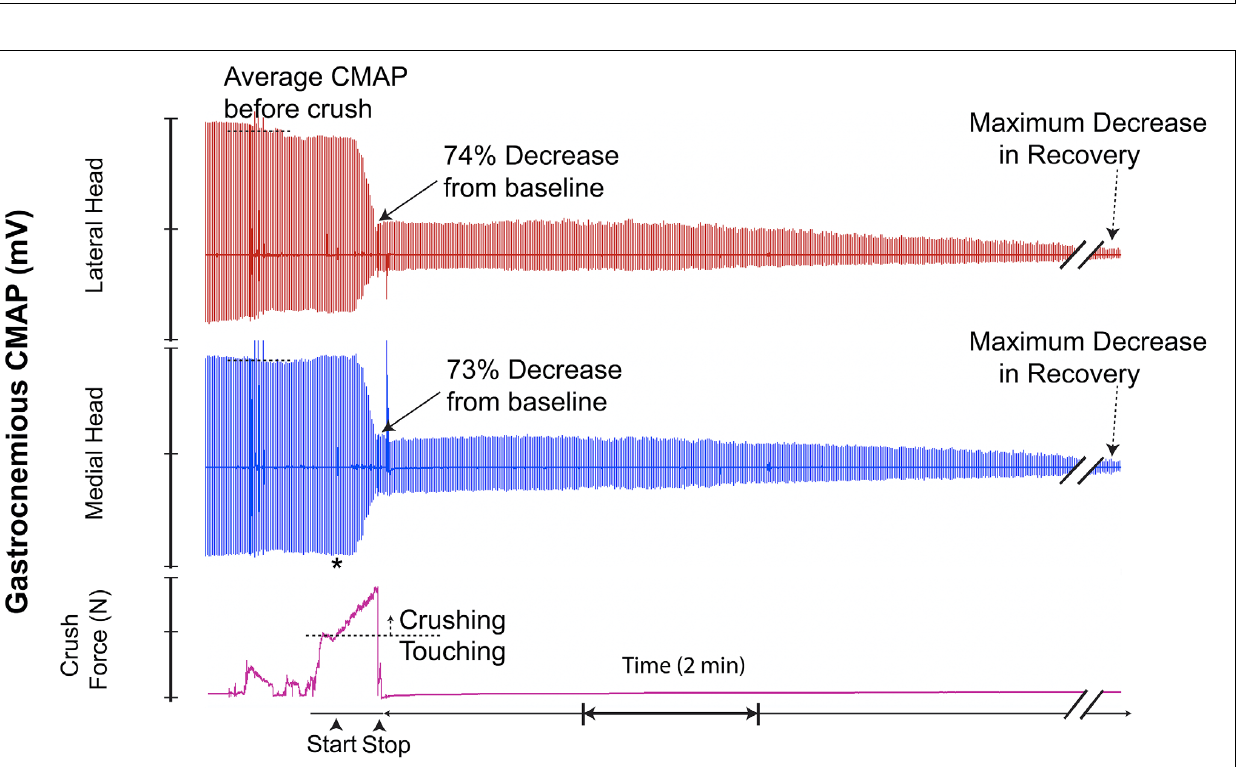
FIGURE 8 | This recording demonstrates crush-induced decline in CMAP amplitude with no recovery and residual electrical activity (non-zero baseline) post-crush. * = beginning of force increase.